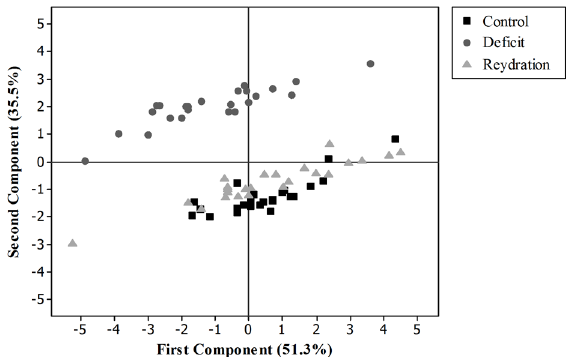
Figure 1 - Distribution of the evaluation periods of safflower lines, according to first and second principal components, irrigated (before water deficit), water deficit (for 30 days), and rehydration (for 18 days).